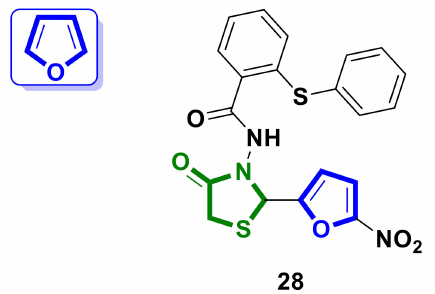
Figure 12. Structure of furan-bearing 4-thiazolidinone hybrid with potent anticancer activity.